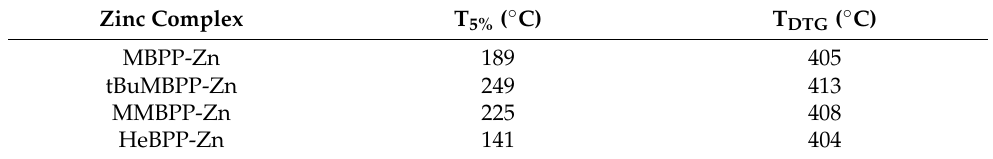
Table 9. Thermal stability of zinc complexes with 1,3-diketones (T 5% , decomposition temperature